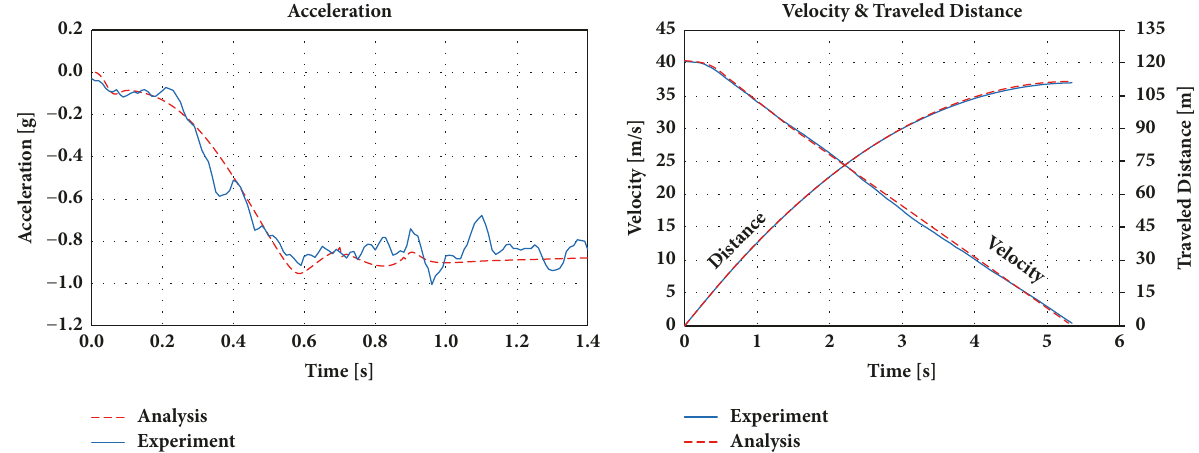
Figure 21: A comparison of the data from the simulations and the road tests.